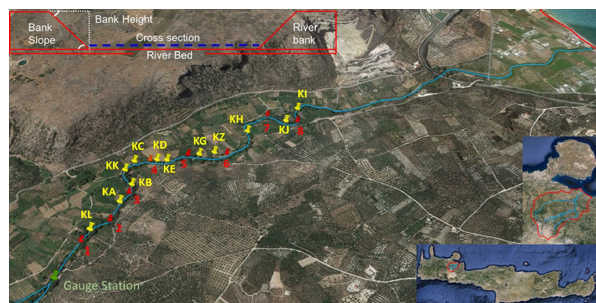
Figure 1. The downstream part of the Koiliaris River, located in the western part of the island of Crete. The yellow pins represent the measurement locations, the red pins the validation locations and the green pin the gauging station located at the intersection of the Koiliaris River with the Keramianos tributary. A representation of the measured geomorphological values is provided in the upper left